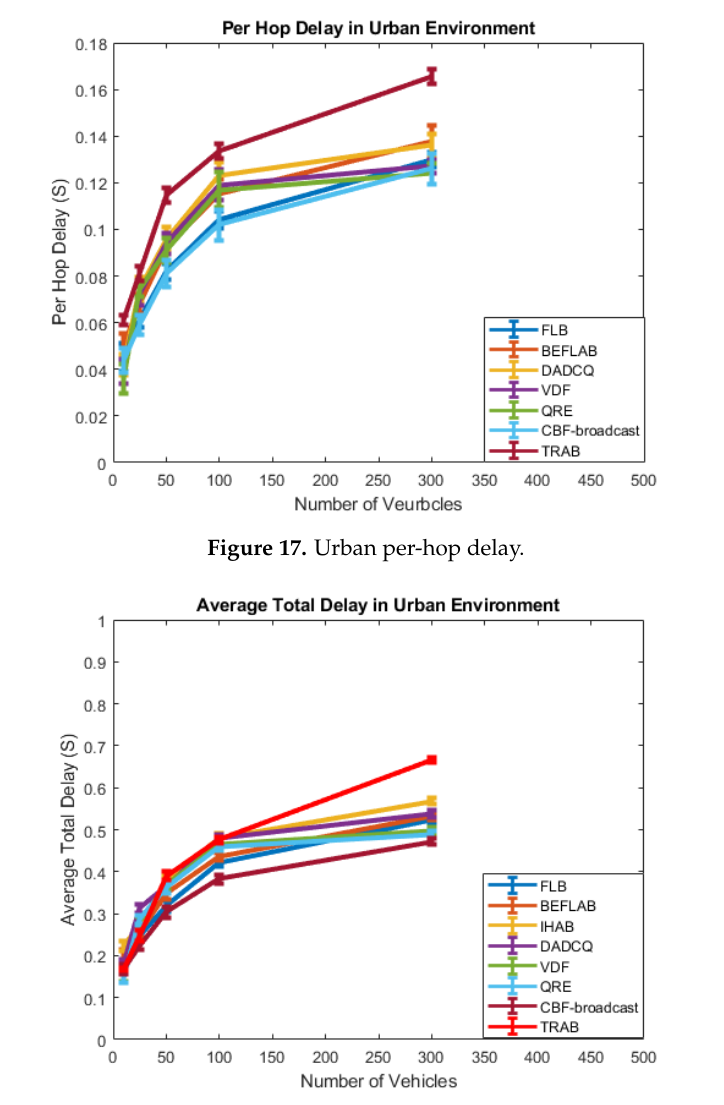
Figure 18. Urban average total